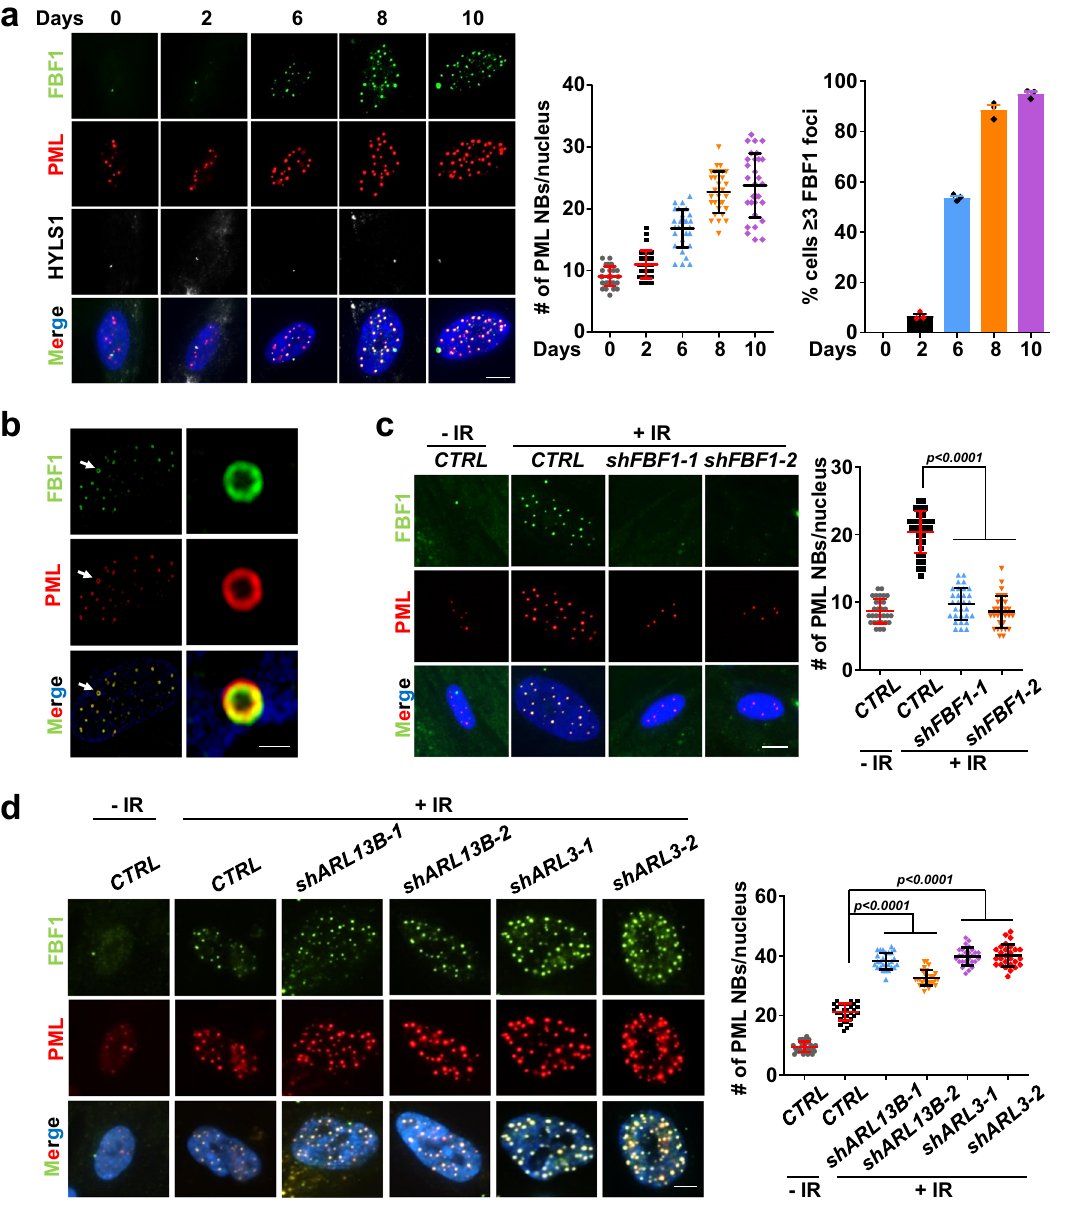
Fig. 3 | ARL13B and ARL3 negatively regulate DNA damage-induced PML-NB translocation ofFBF1, a prerequisite for stress-induced PML-NB upregulation. a Immuno fl uorescent images in IMR-90 cells after irradiation using antibodies against FBF1 and PML. Basal bodies were labeled with HYLS1. Scale bar, 10 μ m. NumberofPMLNBspernucleus( n =30cells)andpercentageofcellscontaining ≥ 3 FBF1 foci after irradiation were quanti fi ed. b Structured illumination microscopic images of the nucleus of a senescent IMR-90 cell stained for FBF1 and PML. Scale bar, 2 μ m. Three experiments were repeated independently with similar results.